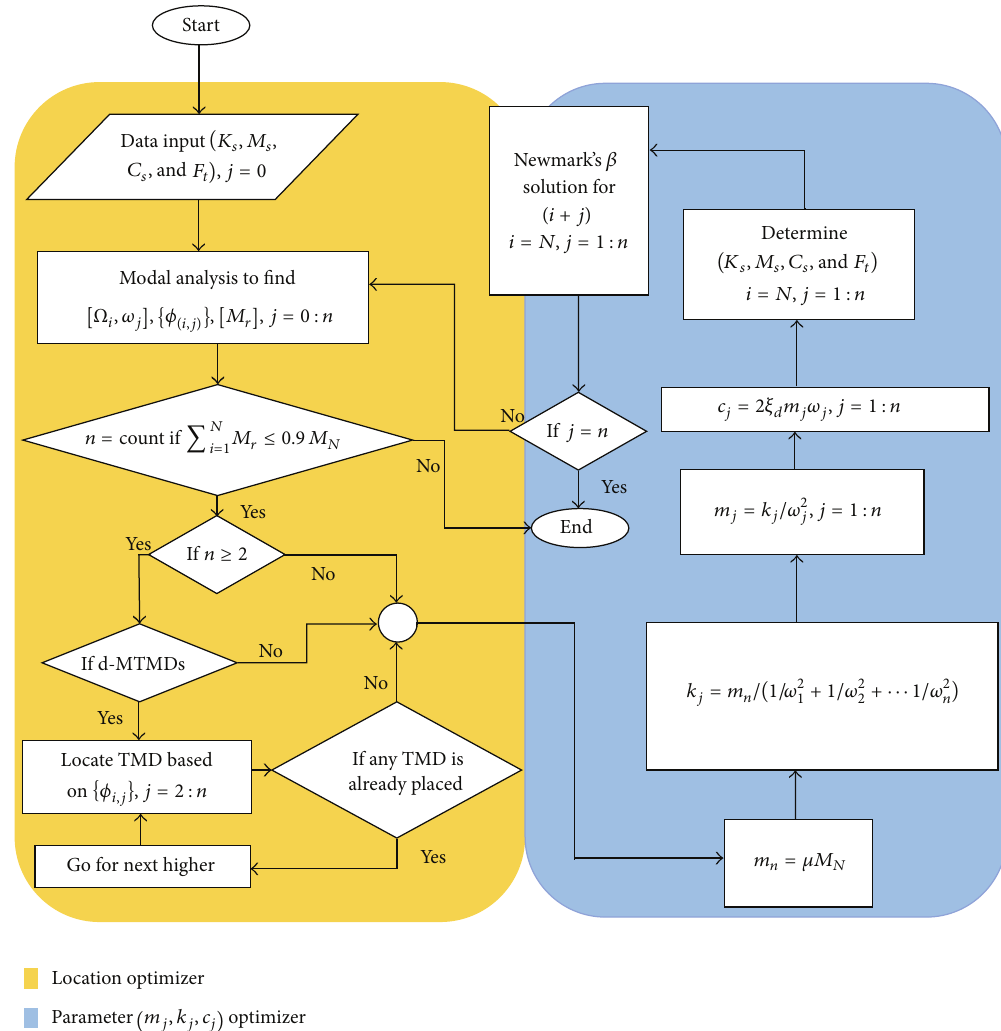
Figure 4: Flowchart for optimizing location and design parameters of d-MTMDs for wind response control of 76-storey benchmark building.